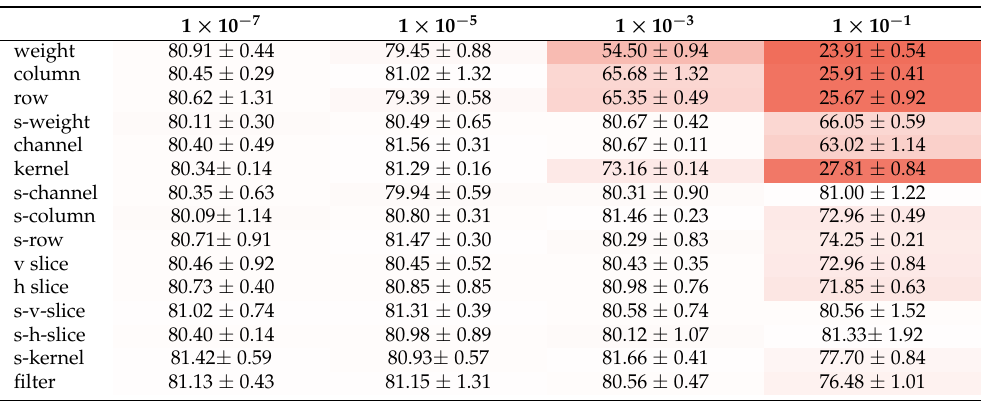
Table 7. Results of regularizing ResNet-18 with 4 different penalty strengths. Mean and standard deviation of accuracy over 3 rounds are reported. The darker the shade of red, the further the accuracy is from the